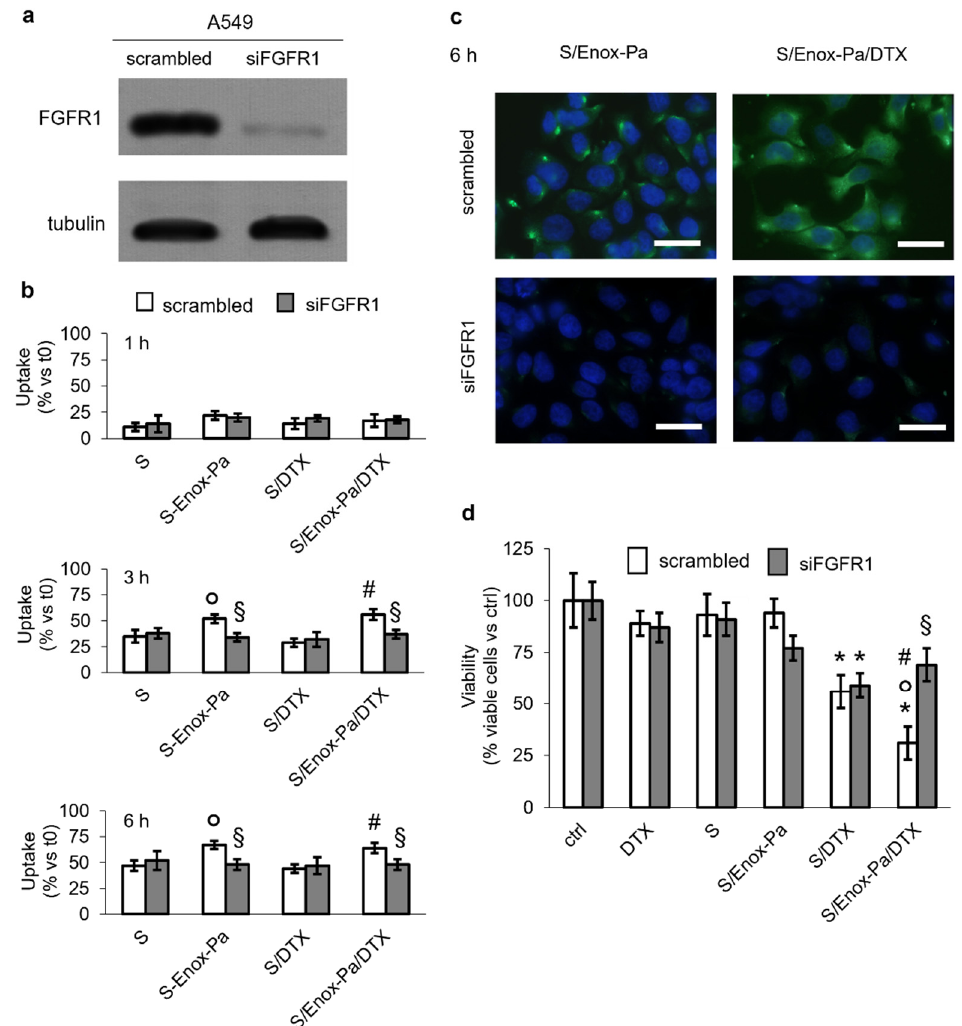
Figure 2. FGFR1 mediates uptake and cytotoxicity of Enox-coated SEDDS containing DTX. A549 cells were treated for 48 h with a non-targeting siRNA (scrambled) or with a pool of three siRNAs targeting FGFR1 (siFGFR1), then subjected to the following investigations. ( a ) Immunoblot of the indicated proteins. Tubulin was used as control of equal protein loading. The image is representative of one out of three experiments. ( b ) Cells were incubated for 1, 3, or 6 h with 0.25% v / v blank SEDDS (S), Enox-coated SEDDS (S/Enox-Pa), SEDDS containing DTX (80 µM final concentration; S/DTX), Enox-coated SEDDS containing DTX (80 µM final concentration; S/Enox-Pa/DTX). The intracellular fluorescence was measured in duplicates and compared to the fluorescence of the solution of each SEEDs before incubation (t0). The results, expressed as % of intracellular fluorescence versus fluorescence at t0, are presented as means ± SD (n = 3). ◦ p < 0.01: S/Enox-Pa vs. S; # p < 0.01: S/Enox-Pa/DTX vs. S/DTX; § p < 0.05: siFGFR1 vs. scrambled cells. ( c ) Representative photographs of scrambled and siFGFR1 A549 cells treated for 6 h with S-E and S-E-d, as in ( b ). The photos are representative of one out of three experiments. For each experimental condition, a minimum of five fields were examined. The photos are representative of one out of three experiments. Ocular: 10×; objective: 60×. Scale bar: 50 µm. ( d ) Cells were incubated with fresh medium (ctrl), 80 µ M free docetaxel (DTX), 0.25% v / v blank SEDDs (S), Enox-coated SEDDS (S/Enox-Pa), SEDDS containing docetaxel (80 µ M final concentration; S/DTX), and Enox-coated SEDDs containing docetaxel (80 µ M final concentration; S/Enox-Pa/DTX) for 72 h. Cell viability was measured by a chemiluminescence- based assay in quadruplicates. Data are presented as means ± SD (n = 3). * p < 0.01: vs. ctrl; ◦ p < 0.01: S/Enox-Pa/DTX vs. DTX; # p < 0.001: S/Enox-Pa/DTX vs. S/DTX; § p < 0.001: siFGFR1 vs. scrambled